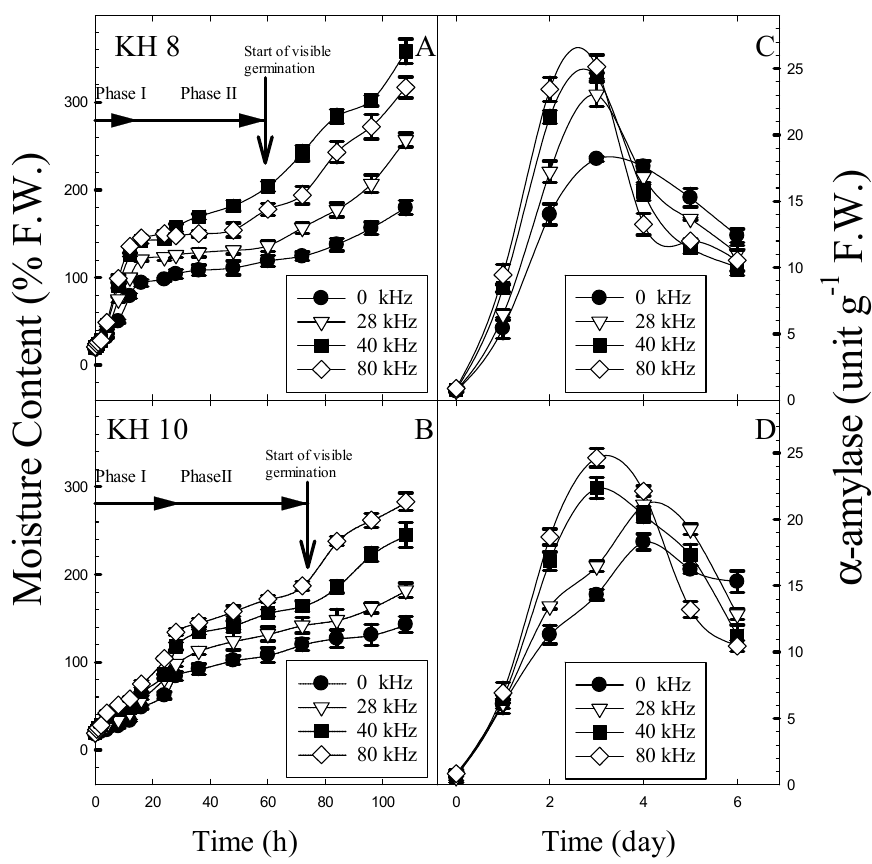
Figure 1. Water absorption and α -amylase activity characteristics of two adzuki bean varieties. Kaohsiung 8 (KH 8) and Kaohsiung 10 (KH 10) seeds were subjected to different ultrasonication treatments (28 kHz, 40 kHz and 80 kHz frequencies for 10 min under 25 °C) during different germination periods.